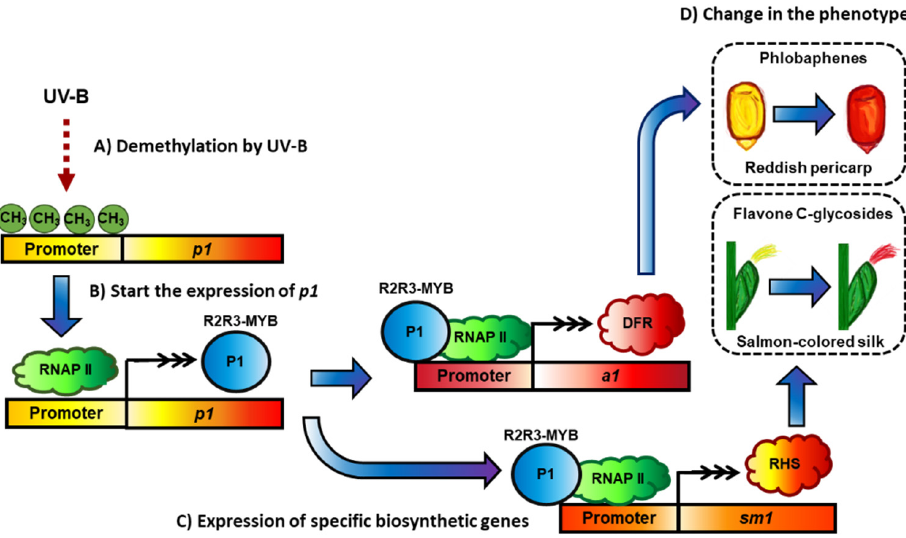
Figure 7. The locus p1 , which regulates the biosynthesis of phlobaphenes and flavone C-glycosides, and its paramutation phenomenon. ( A ) UV-B produces the gene promoter demethylation of p1, with a consequent lower methylation level in the p1 promoter. ( B ) After demethylation, the p1 gene is expressed, and the P1 protein can function as a transcription factor. ( C ) P1 regulates a1 expression, leading to phlobaphene biosynthesis, and also activates essential genes for the flavone C-glucosides, such as sm1, which express the glucose 4,6-dehydratase (RHS). ( D ) The expression of these enzymes modifies the plant